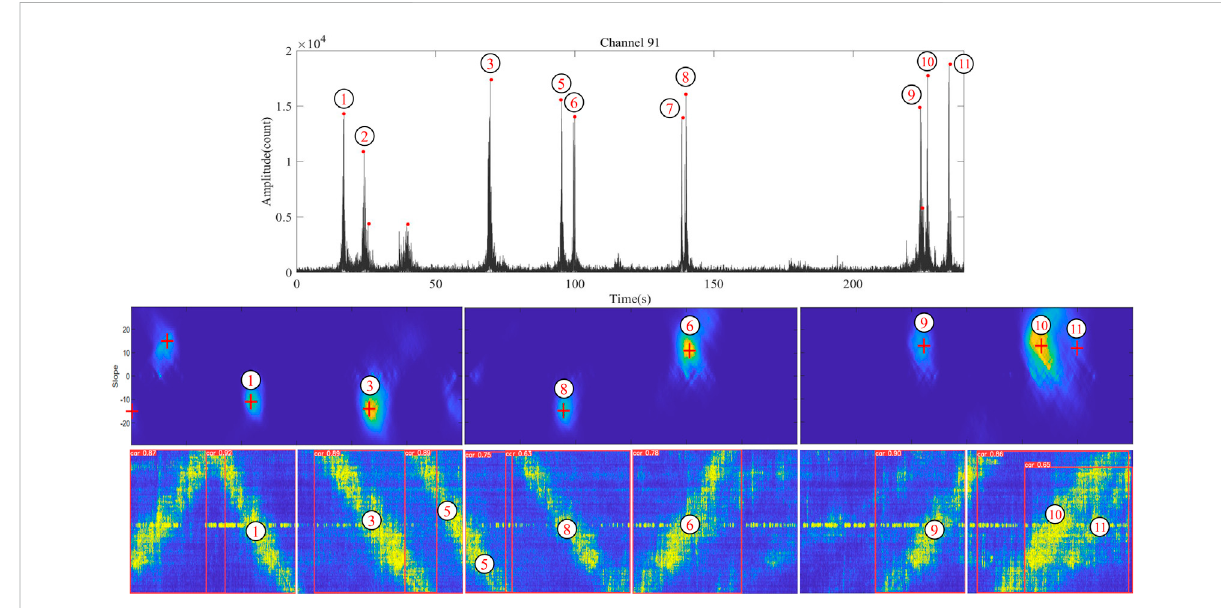
FIGURE 5 Vehicle detection comparisons. The three planes from up to down correspond to the fi ndings of peak detection, slant stacking, and YOLOv5. Their respective detections are indicated by red dots, crosses, and boxes with correlation coef fi cients. The numbers in the circles are identical to those in Figure 4, but their order has altered due to their differing movement orientations. Cars 2, 4, and 7 do not pass through the DAS array on channels 191 – 315.